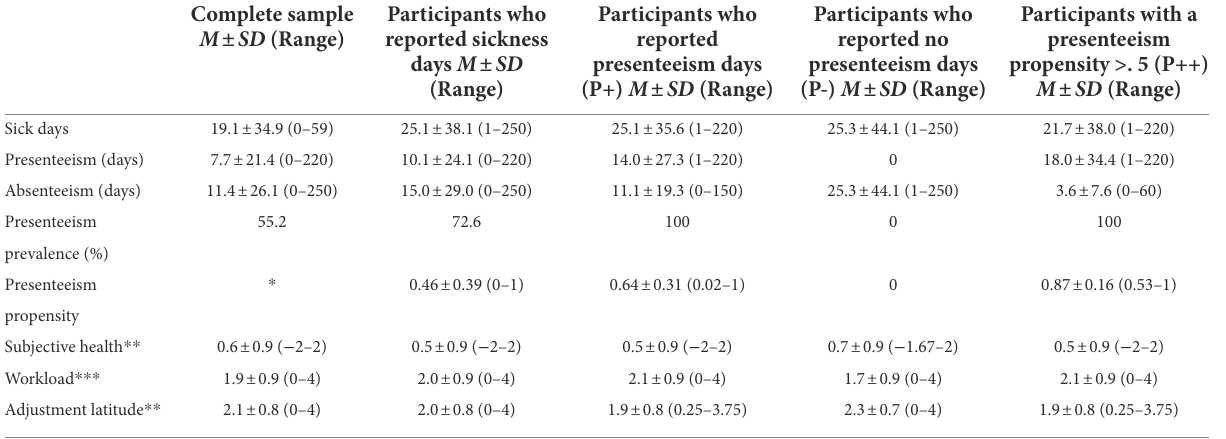
TABLE 3 Results of the descriptive analyses of work-related characteristics of the study